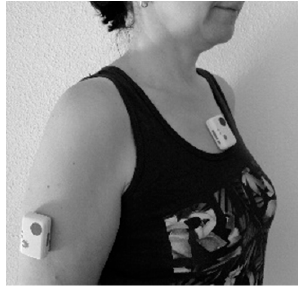
Figure 1. Sensor placement.